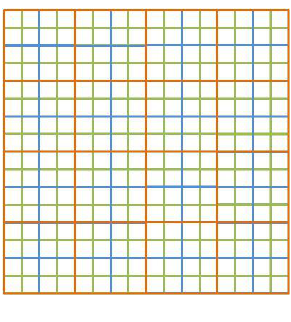
Figure 6. A nested